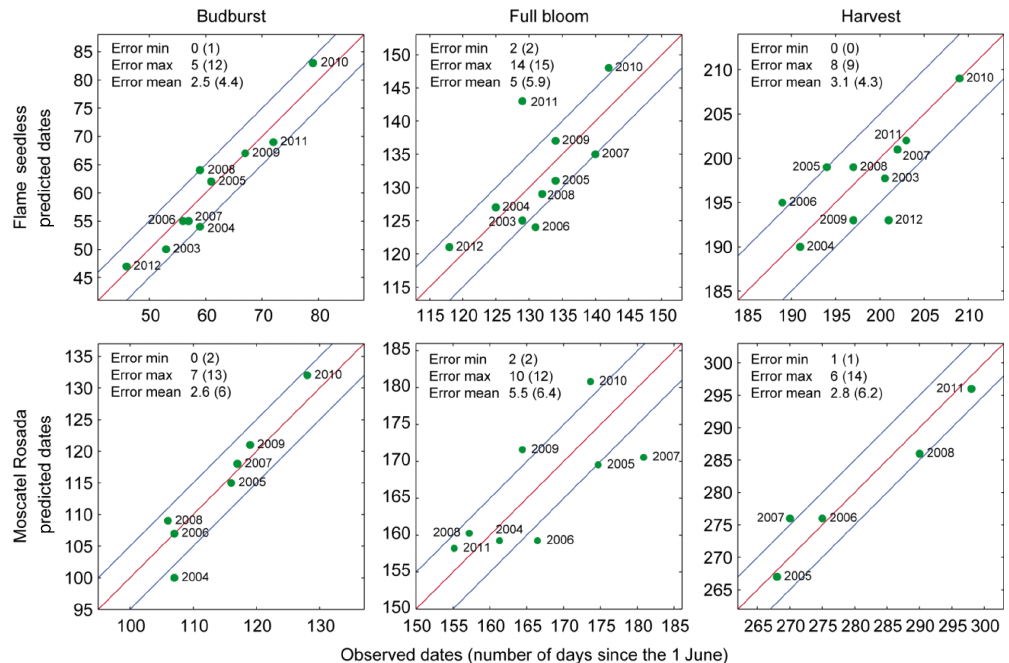
Figure 5. Observed vs. predicted dates of budburst, full bloom and harvest for Flame Seedless and Moscatel Rosada at the INIA experimental site. The dates are expressed in number of days since 1 June. The minimum, maximum and mean absolute errors (in days) are given for each variety and stage of growth (the values between parentheses relate to the validation step, while the values in front of the parentheses relate to the calibration step). The upper and lower blue lines indicate delays of ± 5 days between observed and predicted dates, respectively. Table 2. Goodness-of-fit (calibration) and predicting performance (validation) of the phenological models. RMSE, root mean square error; NSE, Nash–Sutcliffe efficiency; Bias, mean difference between the observed and predicted dates; BB, budburst; FB, full bloom; HV, harvest. Calibration (whole data